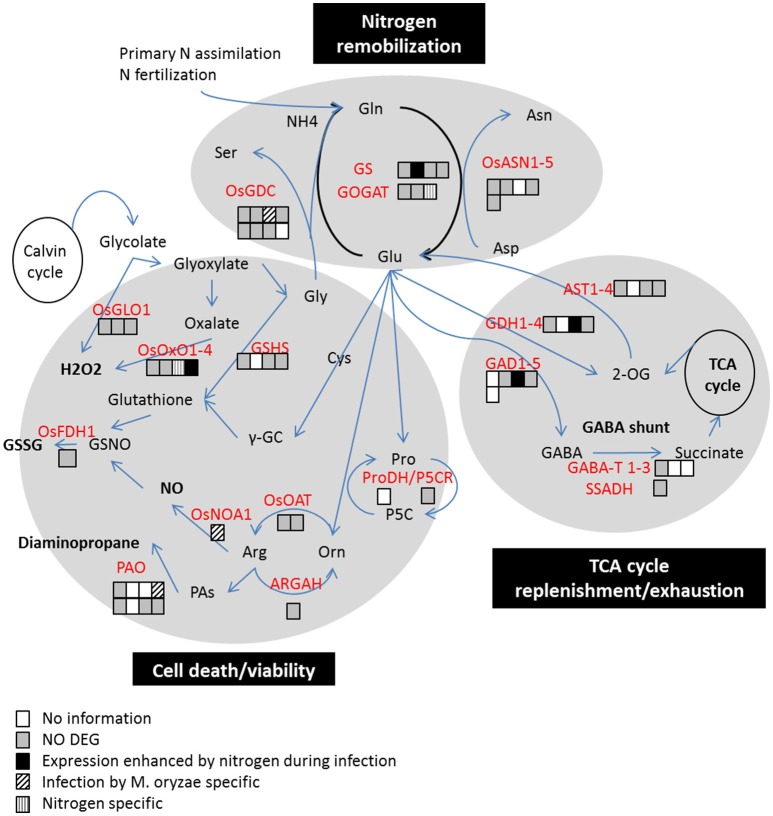
Three major pathways potentially in conflict between the host metabolism and pathogen virulence. Adapted from Seifi et al. (2013). Differential expression in RNA-seq at 2 dpi are represented by colored squares for each gene coding for key enzyme. The patterns refer to categories described in Figure 3. The main enzymes implicated in the nitrogen remobilization away from infected tissues are GS, Gln Synthetase; GOGAT, Glutamate synthase; GDC, glycine decarboxylase; ASN, Asn synthetase. The main enzymes implicated in the cell death pathway linked to GS/GOGAT are ProDH, Proline dehydrogenase; ARGAH, P5C reductase, arginase; OAT, Ornithine carbamoyl transferase; NOS, nitric oxide synthase; PAO, polyamine oxidase; GSHS, glutathione synthetase; OsOXO1-4, Oxalate oxidases; OsGLO1, glycolate oxidase. The main enzymes for TCA cycle and GABA-shunt pathways are AST, Asp transaminase; GDH, glutamate dehydrogenase; GAD, glutamate decarboxylase; GABA-T, and SSADH.